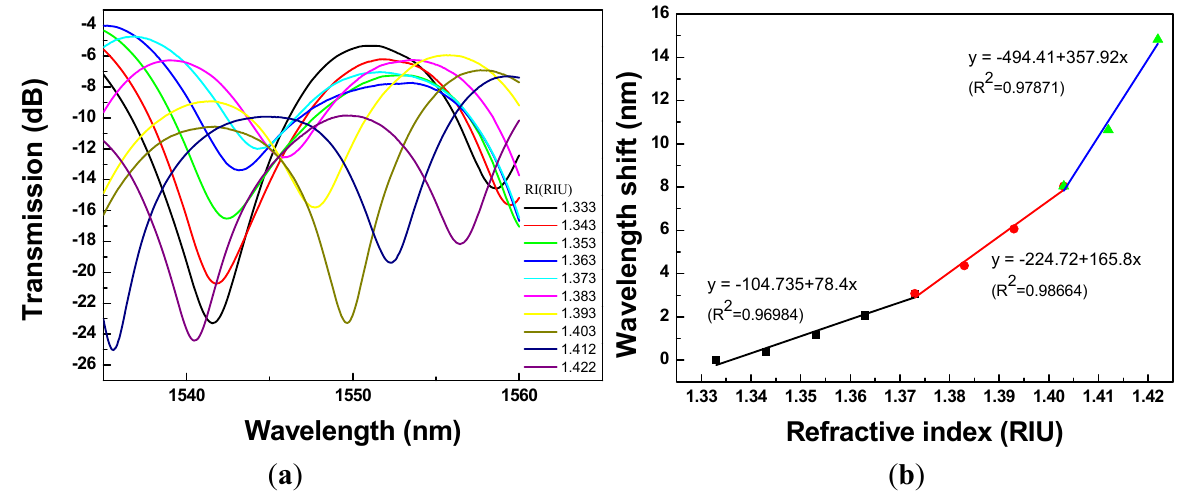
Figure 11. A 4.40-cm PCF interferometer with: ( a ) the transmission spectra for sensing different refractive indices of the sucrose solution (RI =1.333 − 1.422); ( b ) the relationship between wavelength shift versus refractive index (resonance wavelength = 1,550.42